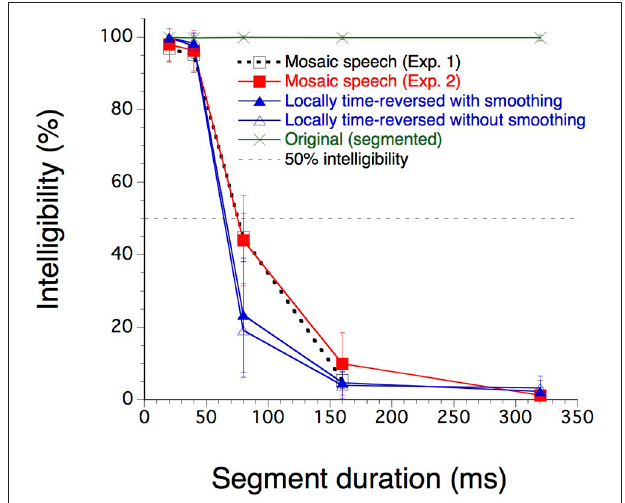
FIGURE 5 | Mora identification scores (%) for the four stimulus conditions ( n = 4 in Experiment 1 and n = 20 in Experiment 2). The dashed horizontal line indicates the 50% level of mora identification. The error bars indicate the standard deviations. Twenty-four participants were asked to write down what they heard in Japanese hiragana letters, indicating morae–based phonological units of Japanese, which are in many cases equal to and sometimes shorter than